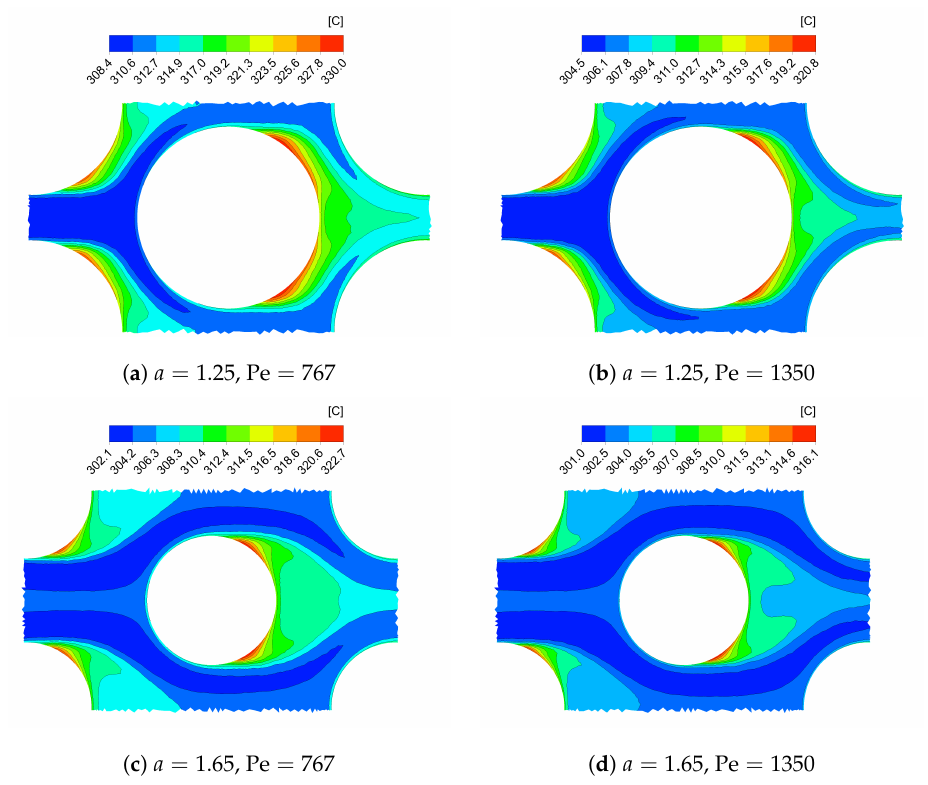
Figure 11. Temperature distribution in the subchannel centered around the central rod of the fifth column of the staggered bundle at Re = 6.11 × 10 4